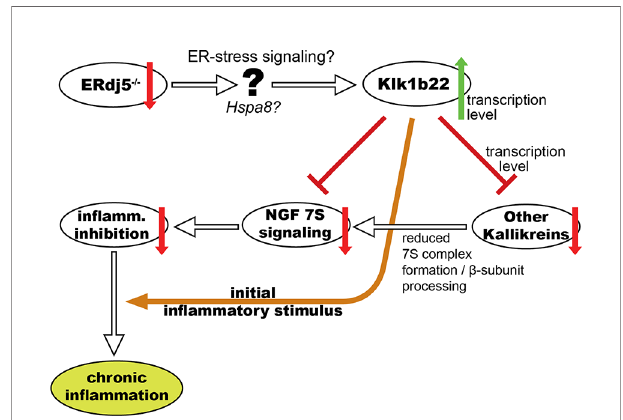
FIGURE 6 | Schematic representation of our working mechanistic model for the involvement of ERdj5 ablation, ER-stress and kallikrein deregulation in the development of an SS-like phenotype in mice through